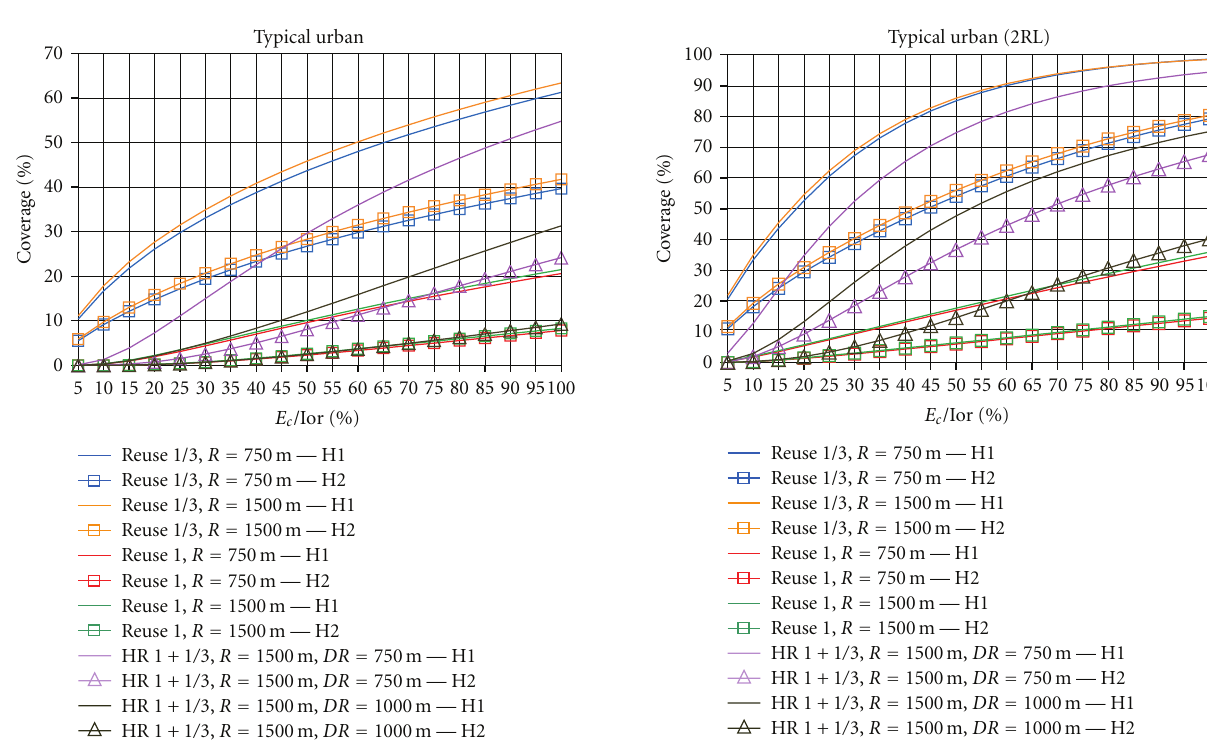
for users outside DR ) are also evaluated. Reuse 1/3 provides higher coverage followed by soft reuse, the smallest coverage belongs to reuse 1. However, none reuse scheme assures 95% coverage.